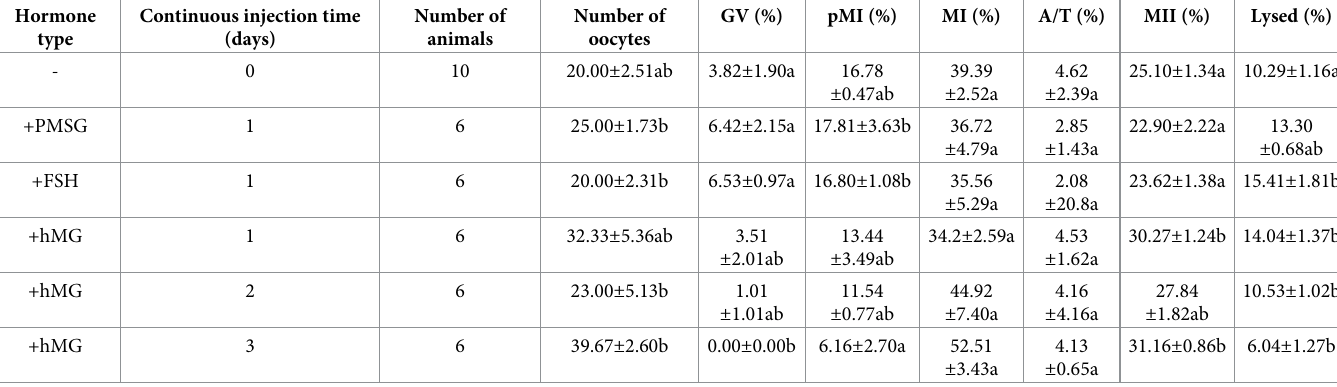
Table 3. Effects of different hormones on superovulation and on the IVM rate of oocytes from these superovulated guinea pigs. Hormone Continuous injection time Number of type (days)